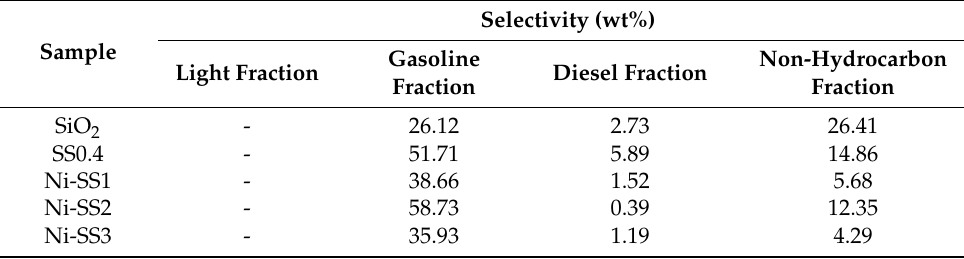
Table 4. Catalyst selectivity test from the catalytic hydrocracking of waste frying